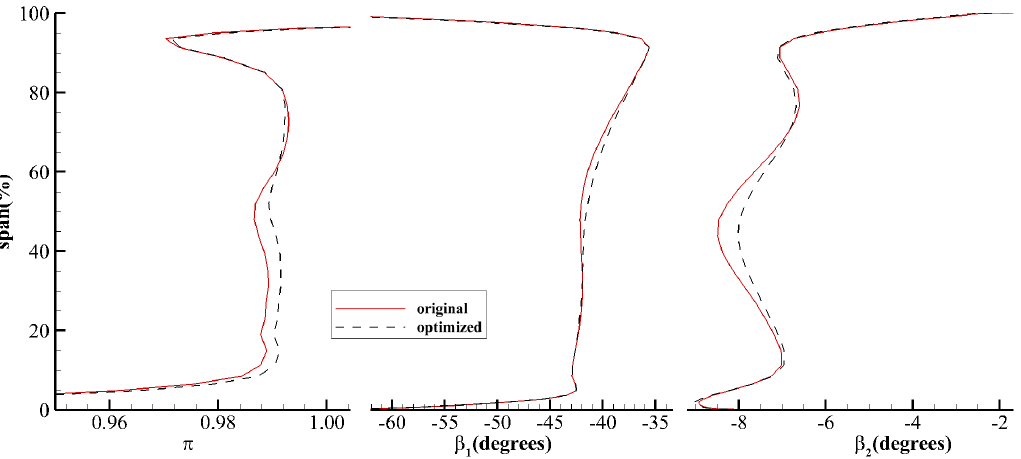
Figure 21. Radial distributions of stator aerodynamic parameters calculated across the stator only at the peak efficiency point for the NASA Stage 35.